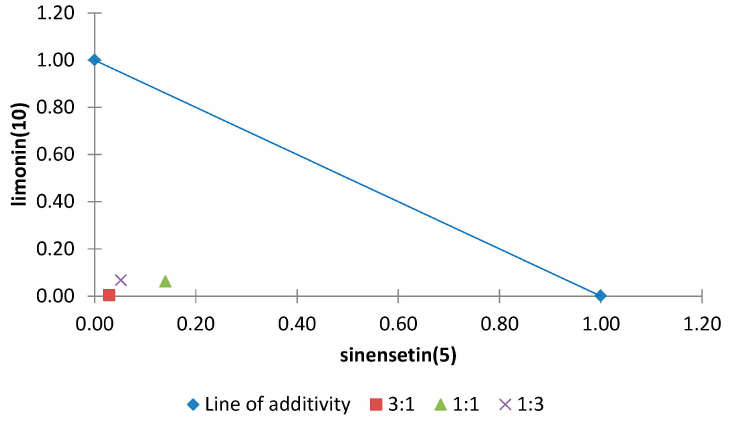
Figure 13. Normalized isobologram (ED 25 ) for the binary mixture sinensetin ( 5 )/limonin ( 10 ) in the etiolated wheat coleoptile bioassay. (Combination ratios 3:1; 1:1; 1:3). All ratios are located below